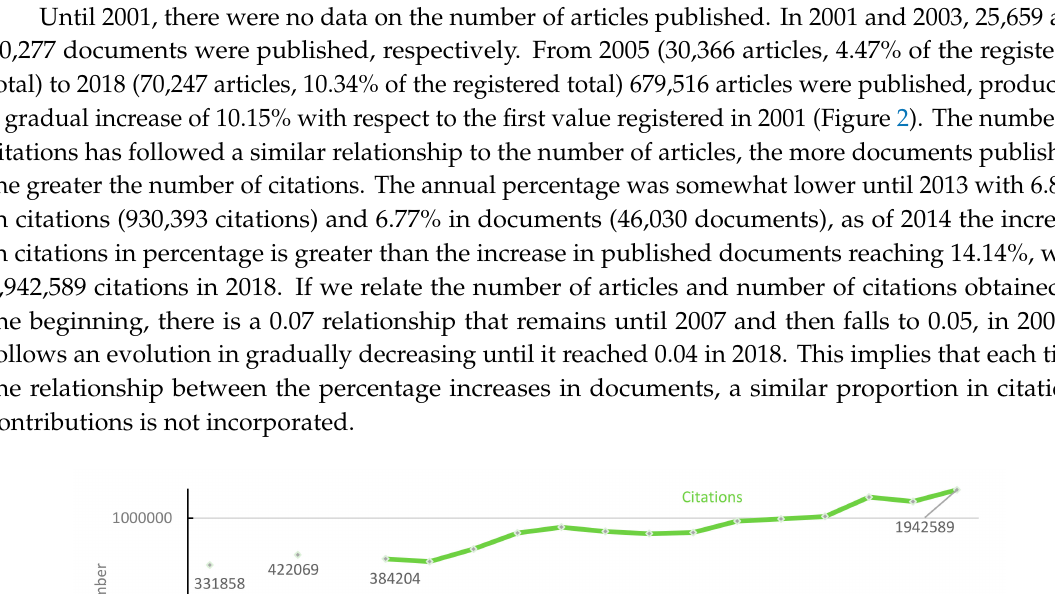
Figure 1. Evolution of the Engineering, Electrical and Electronic category and relationship with the journal Electronics.